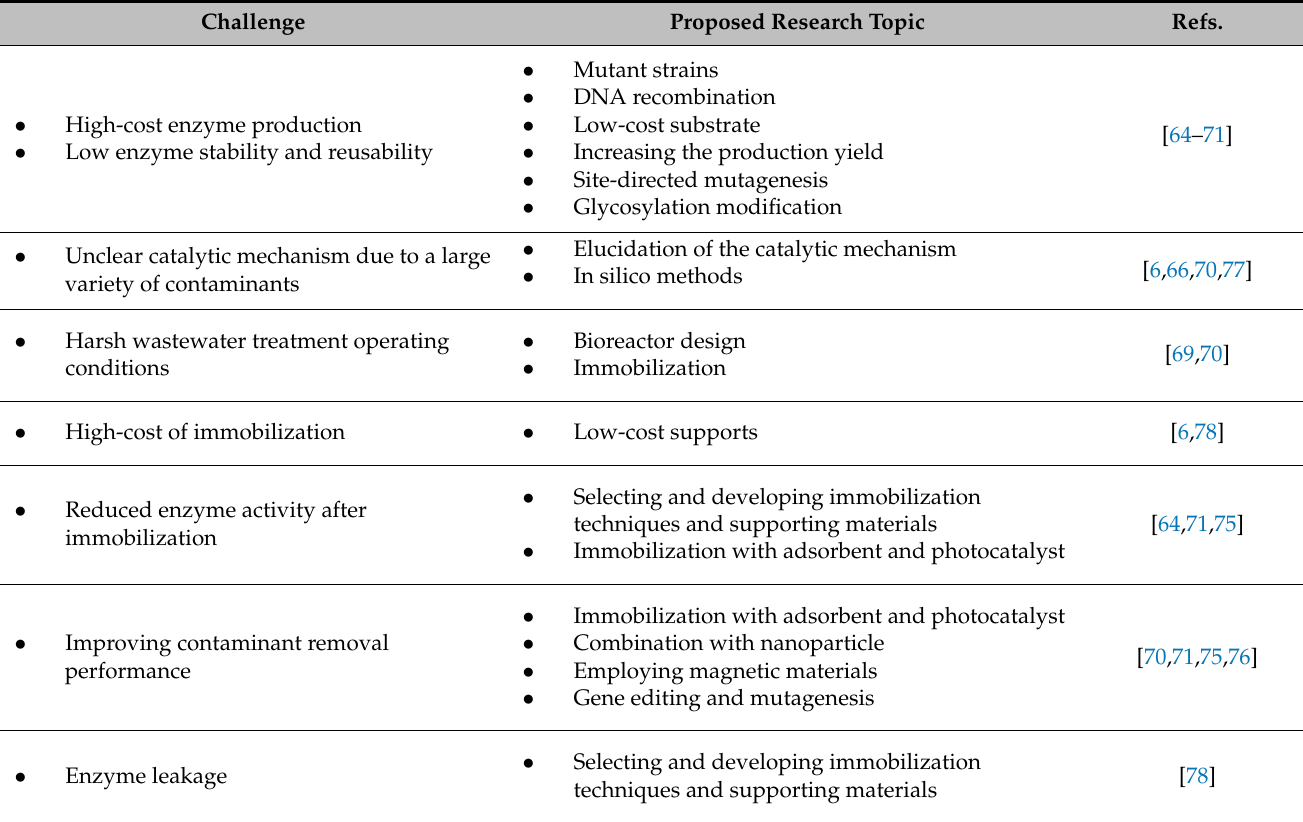
Table 7. Challenges and future research agenda for laccase-assisted wastewater